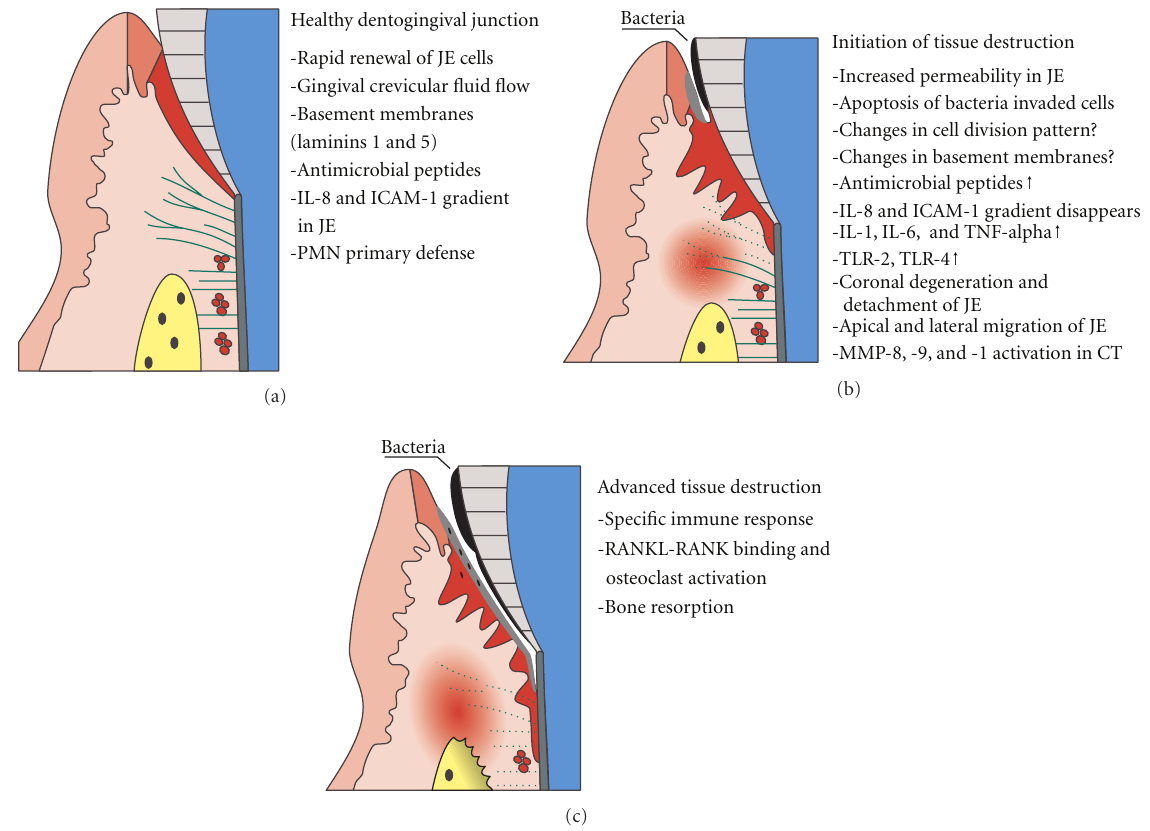
Figure 1: (a) Healthy dentogingival junction is an active part of the innate periodontal defense. (b) The epithelium and connective tissue are a ff ected at the initial phase of periodontal tissue destruction. (c) In periodontitis the epithelial barrier is broken, bacteria may invade the tissue (black spots), and connective tissue and bone are degraded. Junctional epithelium, dark red. Connective tissue and periodontal ligament fibers green, and bone yellow. Bacteria black, pocket epithelium light gray. (a) Is a modified version of a figure from P¨oll¨anen et al.